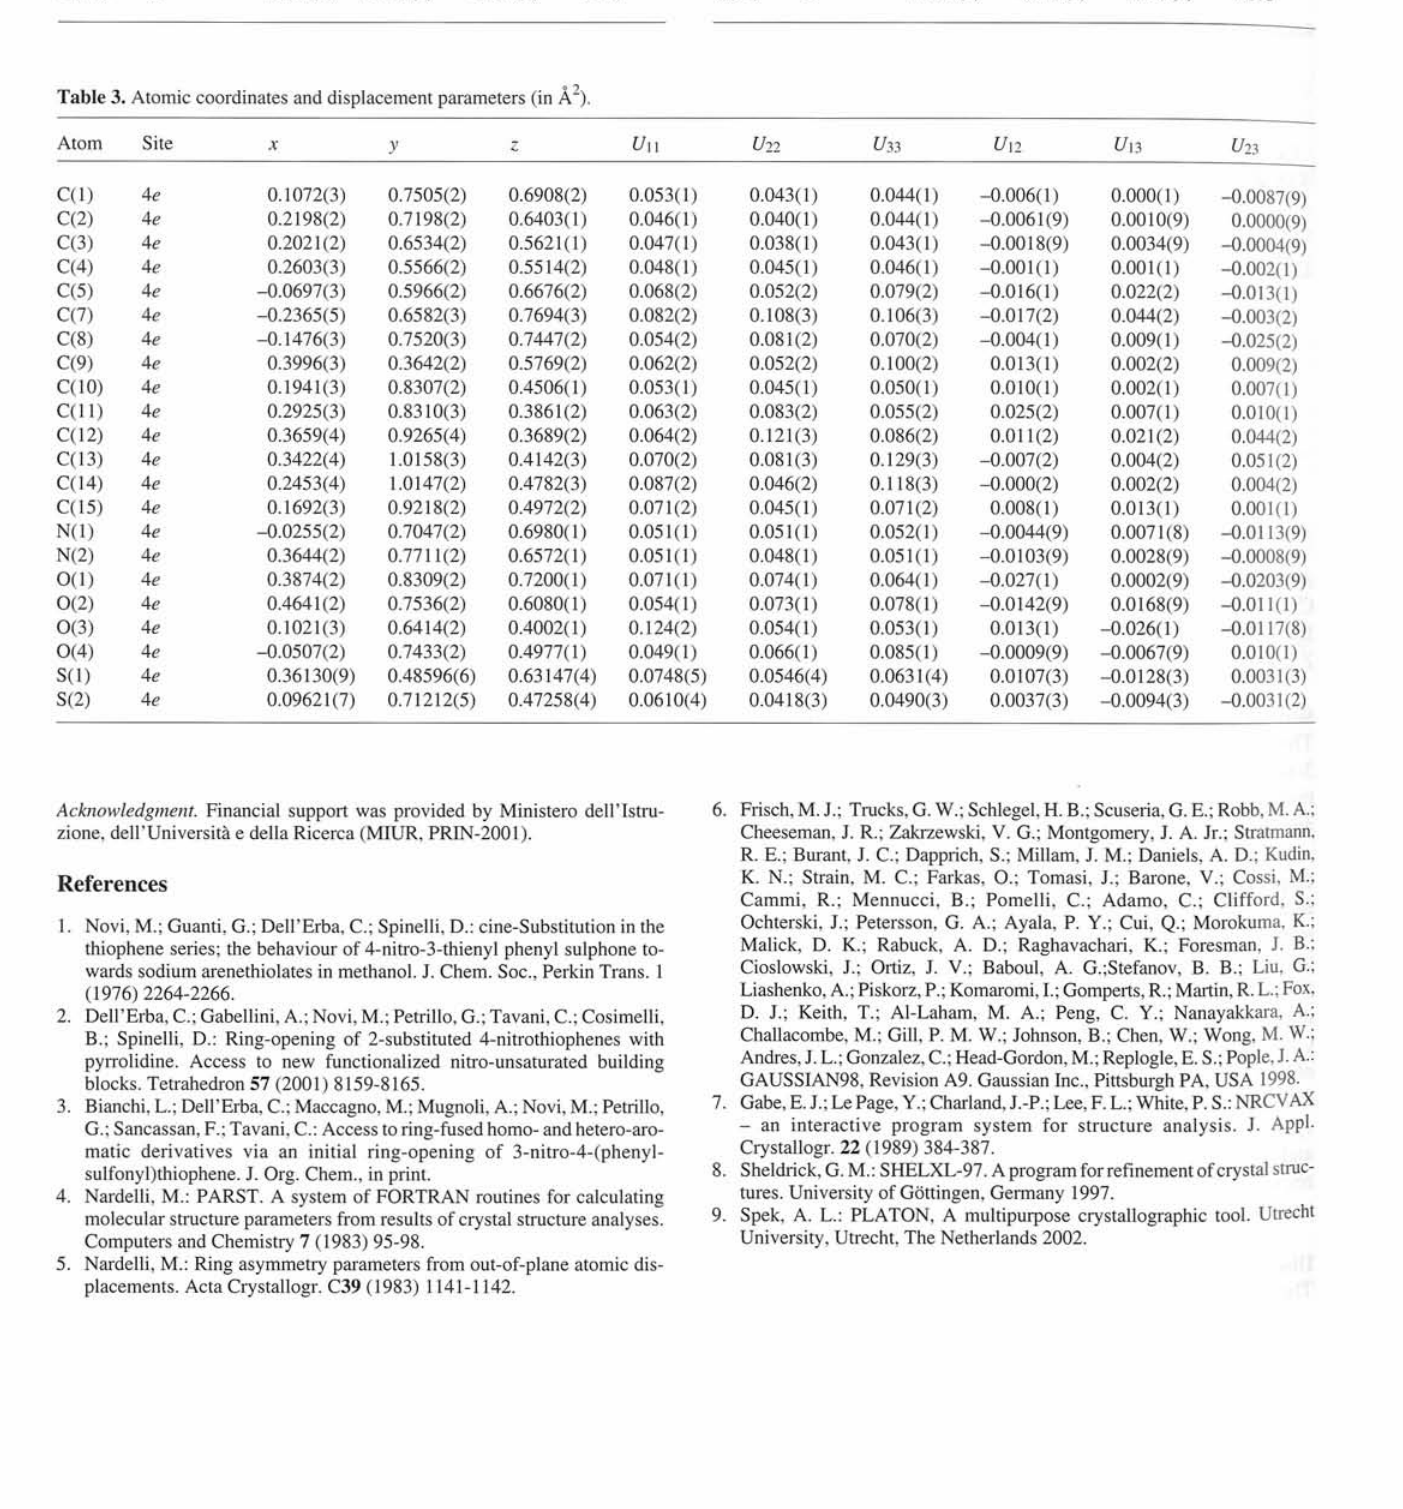
Table 3. Atomic coordinates and displacement parameters (in Â 2